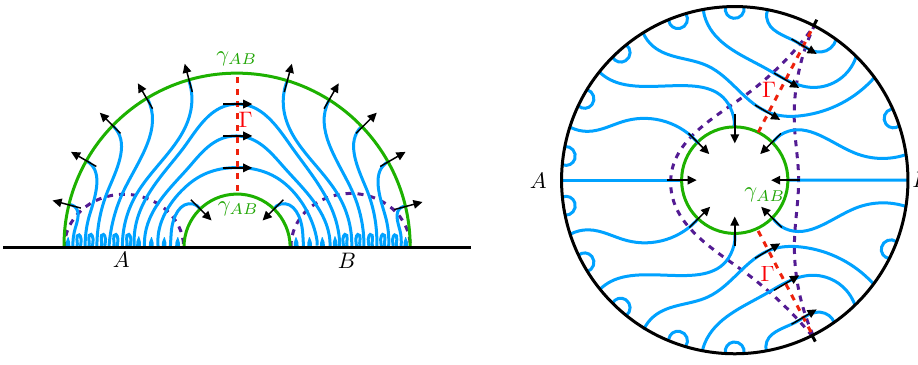
Figure 5 . Representative examples of bit thread con(cid:12)gurations simultaneously maximizing the (cid:13)ow through the entanglement wedge surface (cid:0) (red dashed line) and RT surface (cid:13) AB (green line). The vector (cid:12)elds specifying the (cid:13)ow are indicated on (cid:13) AB and (cid:0) by arrows, and the individual RT surfaces for A and B are depicted with purple dashed lines. Left: A and B are two surfaces de(cid:12)ning a proper subregion of a single boundary, on which the CFT state is pure. Right: A and B partition an entire boundary, on which is de(cid:12)ned a mixed CFT state, resulting in a horizon in the bulk. cross section (cid:0) and the RT surface (cid:13) AB . As mentioned above, this is always possible